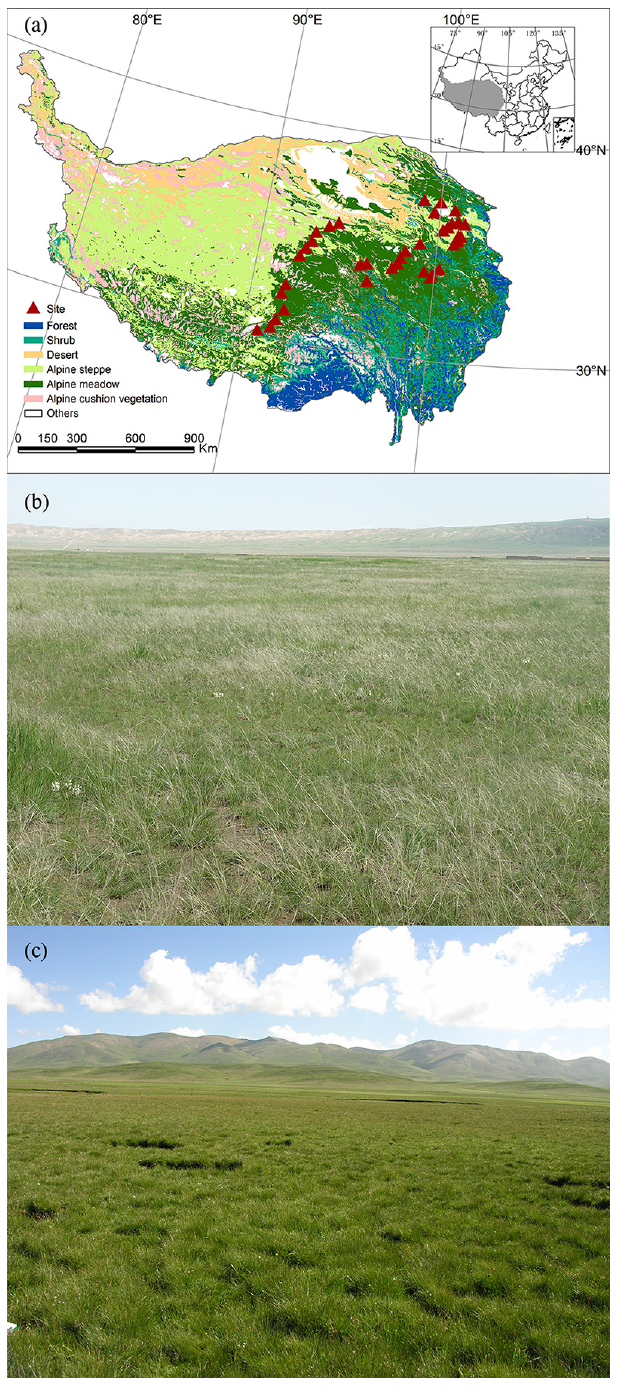
Fig. 1. Geographical distribution of the sampling sites against the background map of the vegetation of the Tibetan Plateau (1 : 1000000; Chinese Academy of Sciences, 2001) (a) , the landscape of alpine steppe (b) and alpine meadow (c) (photo by Jin-Sheng